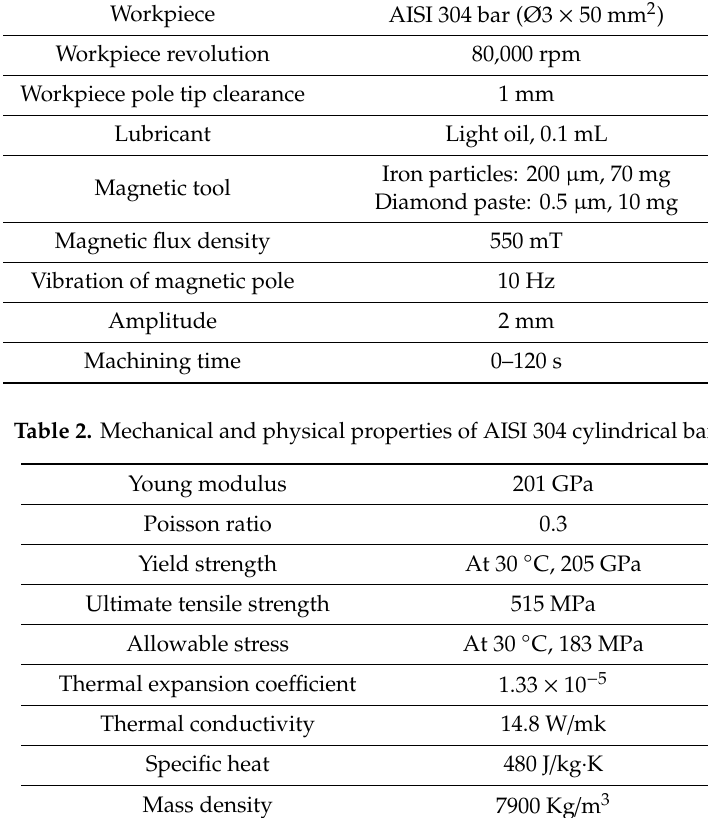
Table 1. Experimental conditions.